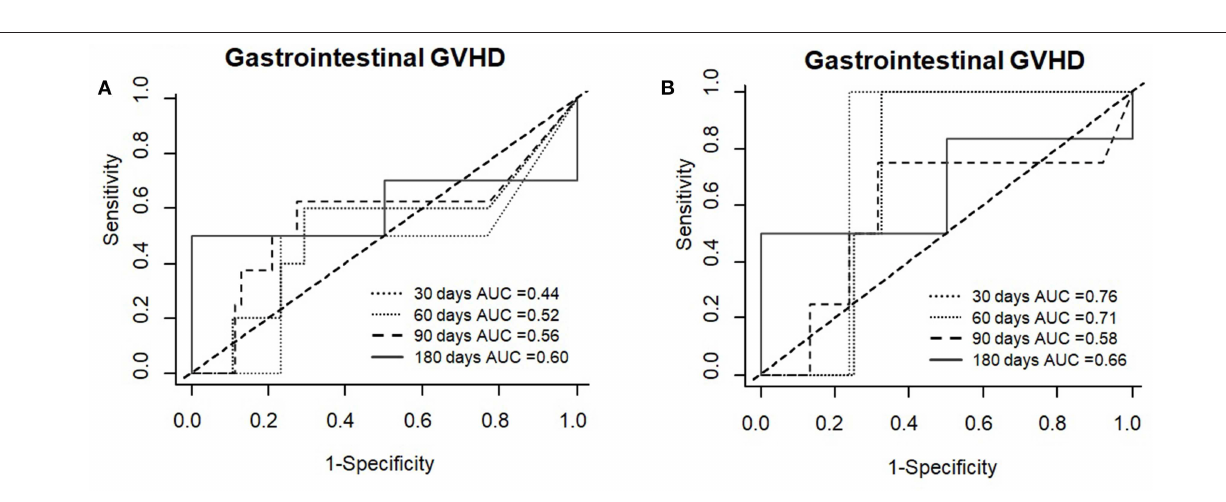
FIGURE 5 | Time-dependent ROC curves for gastrointestinal GVHD using REG3 α levels at day + 30 in both, the whole cohort (A) and the RIC cohort (B)